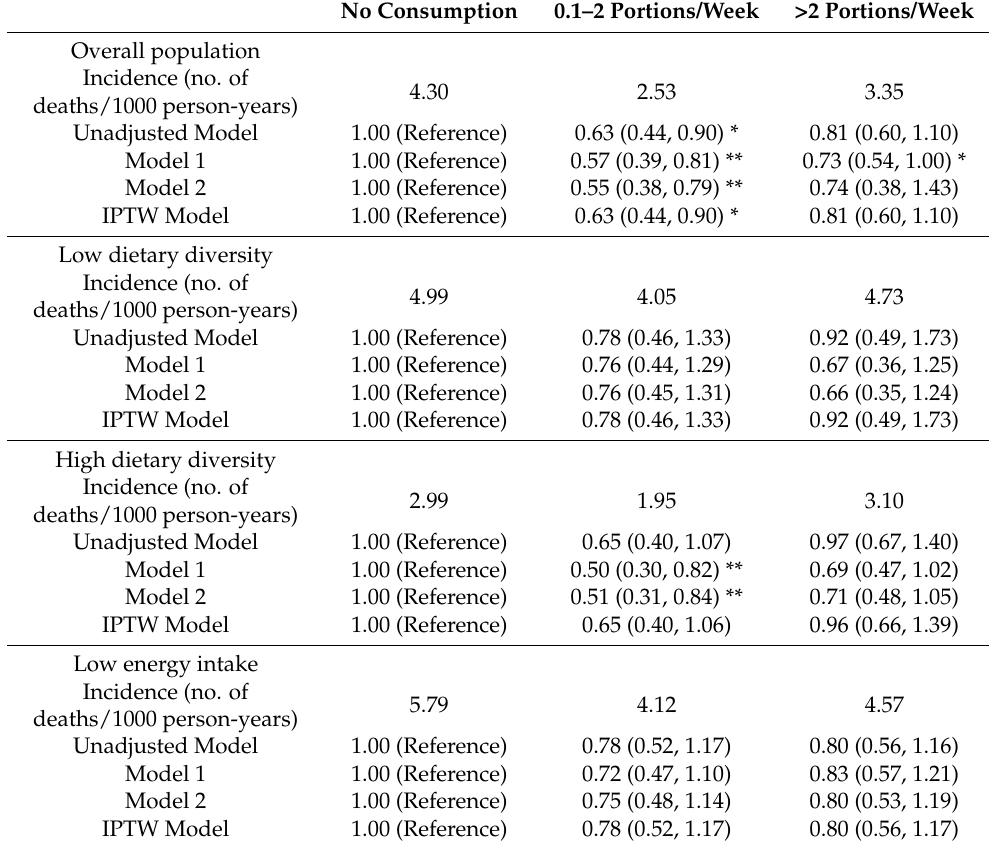
Table 3. Association between average milk intake and all-cause